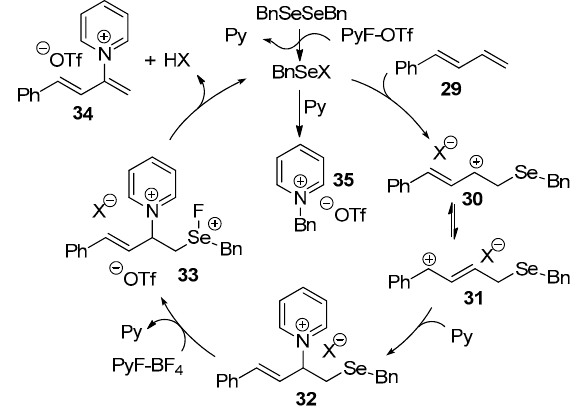
Scheme 12. Proposed mechanism of regioselective pyridination of 1,3-dienes.